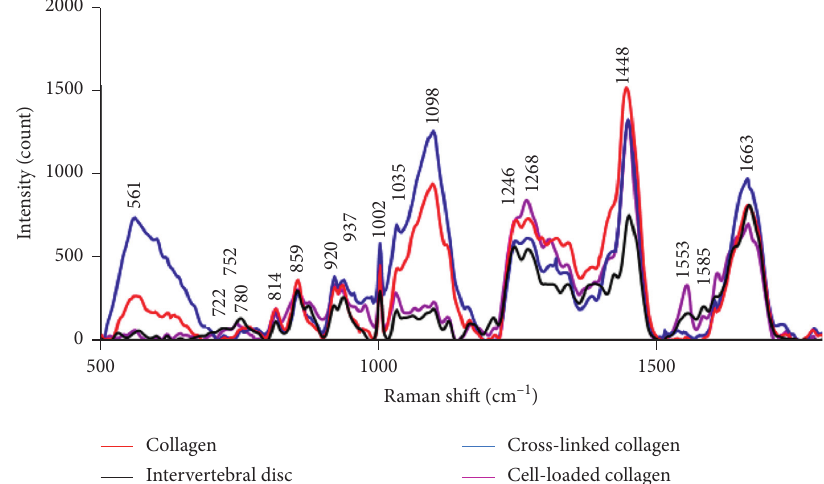
Figure 7: Comparing Raman spectra of four different specimens including, non-cross-linked collagen, cross-linked collagen electrospun scaffolds, cell-loaded cross-linked collagen electrospun scaffold, along with naive intervertebral disc for content.